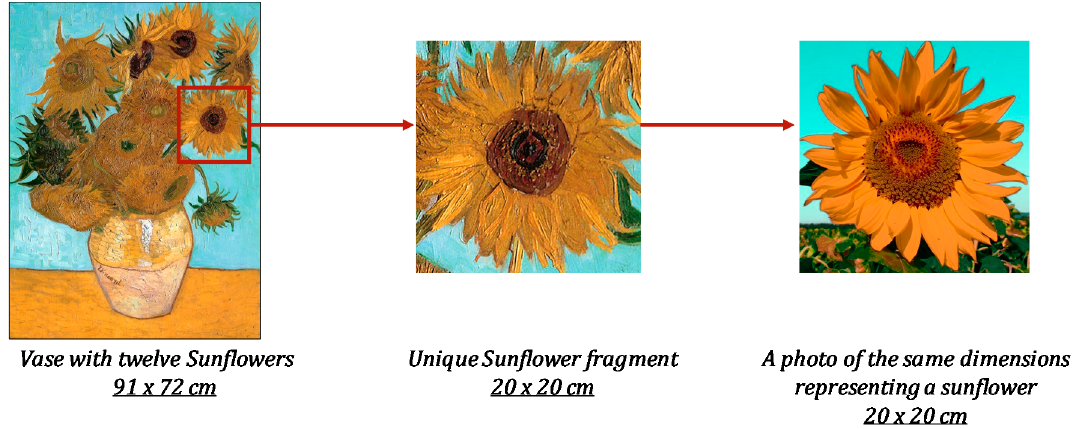
Figure 4. Schematic representation of the selection process of a subject for reproduction .